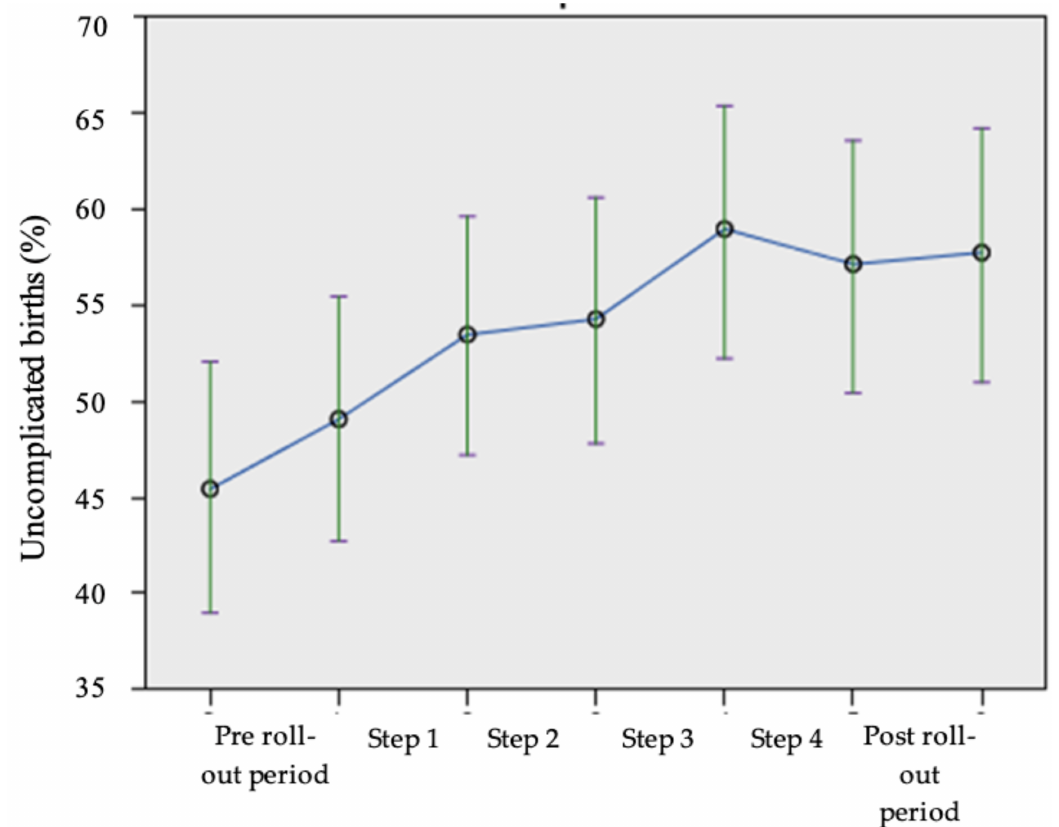
Figure 4. Total percentage (control and intervention group) uncomplicated births in each step of the study. Error bars represent 95% confidence